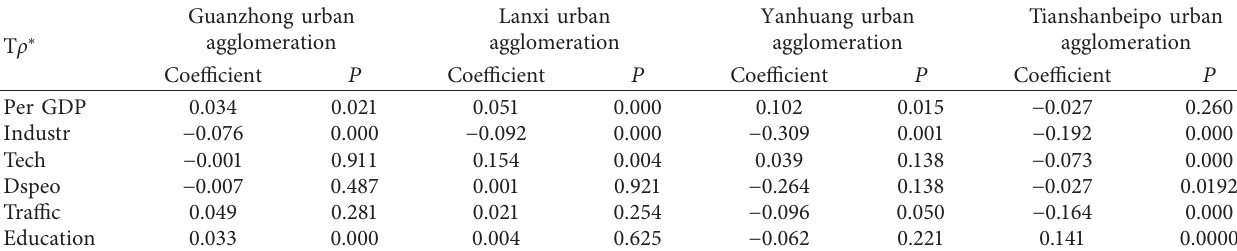
Table 5: Tobit regression of urban